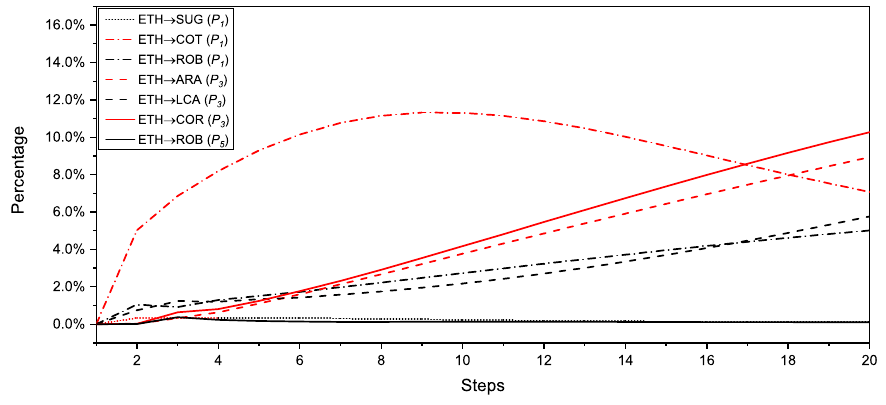
Figure 5. The forecast error variance decomposition (FEVD) of the ethanol prices in the agricultural commodities prices.